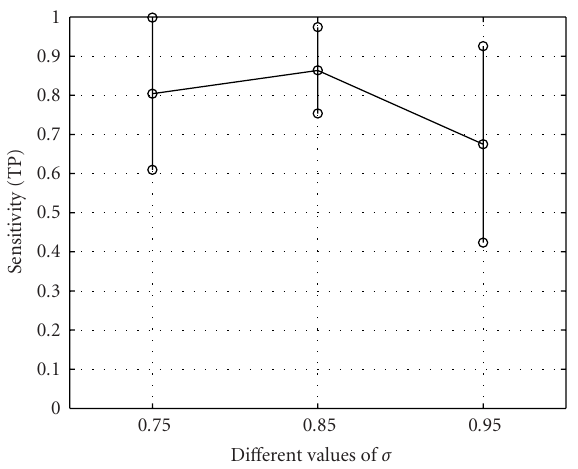
Figure 9: E ff ect of the di ff erent σ values in the Canny edge detector on the sensitivity of system towards identifying a cell. Mean sensi- tivity derived from 16 testing images: 0 . 8 when σ = 0 . 75; 0 . 86 when σ = 0 . 85; and 0 . 67 when σ = 0 . 95.